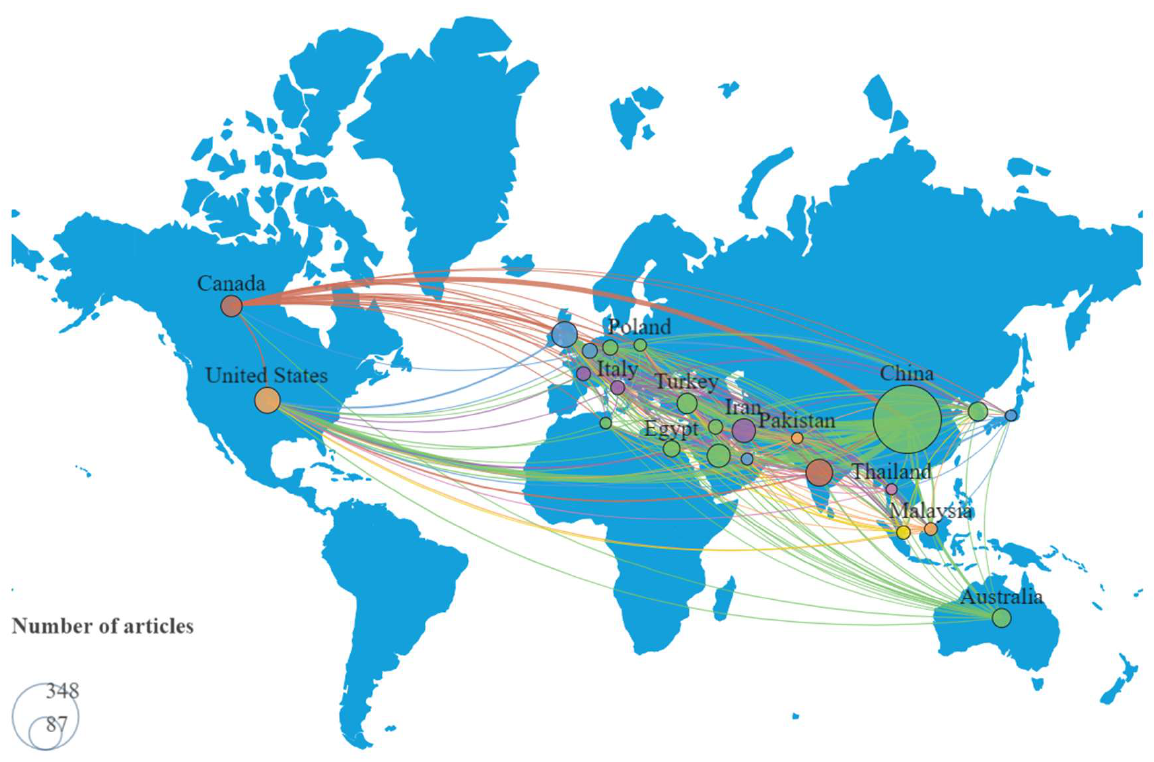
Figure 2. Relationship between